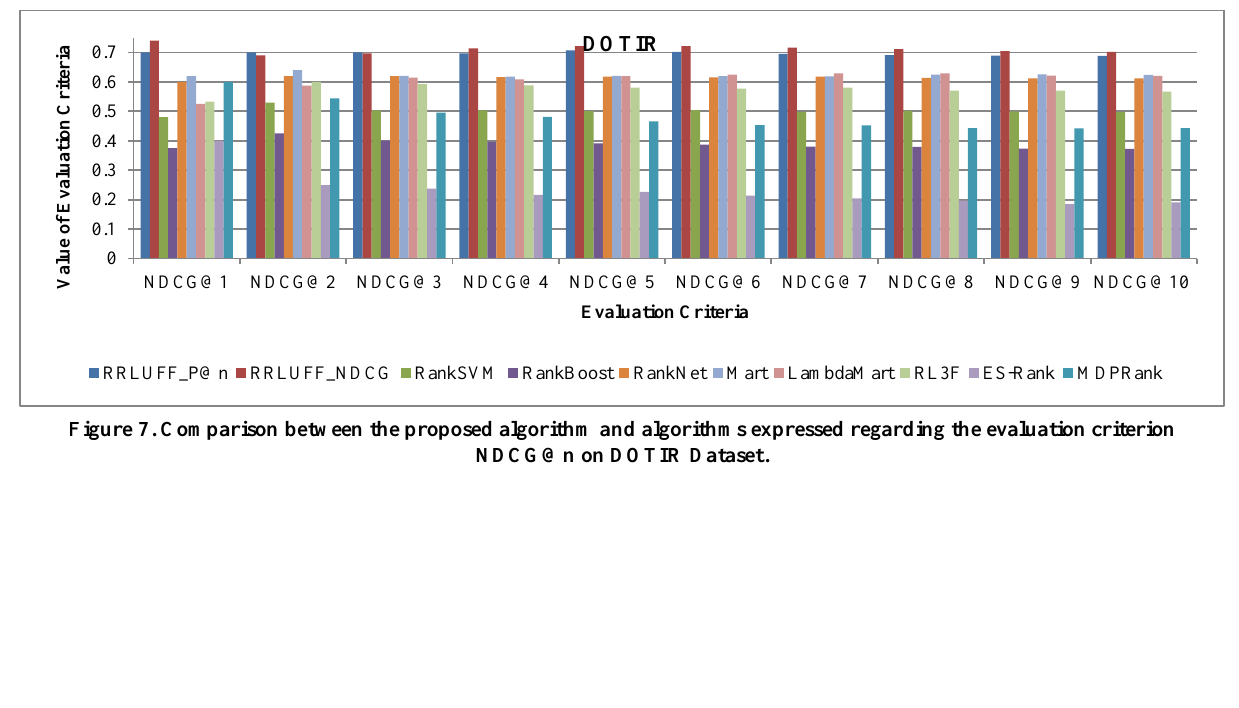
Figure 6. Comparison between the proposed algorithm and algorithms expressed regarding the evaluation criterion P@n on OHSUMED Dataset.